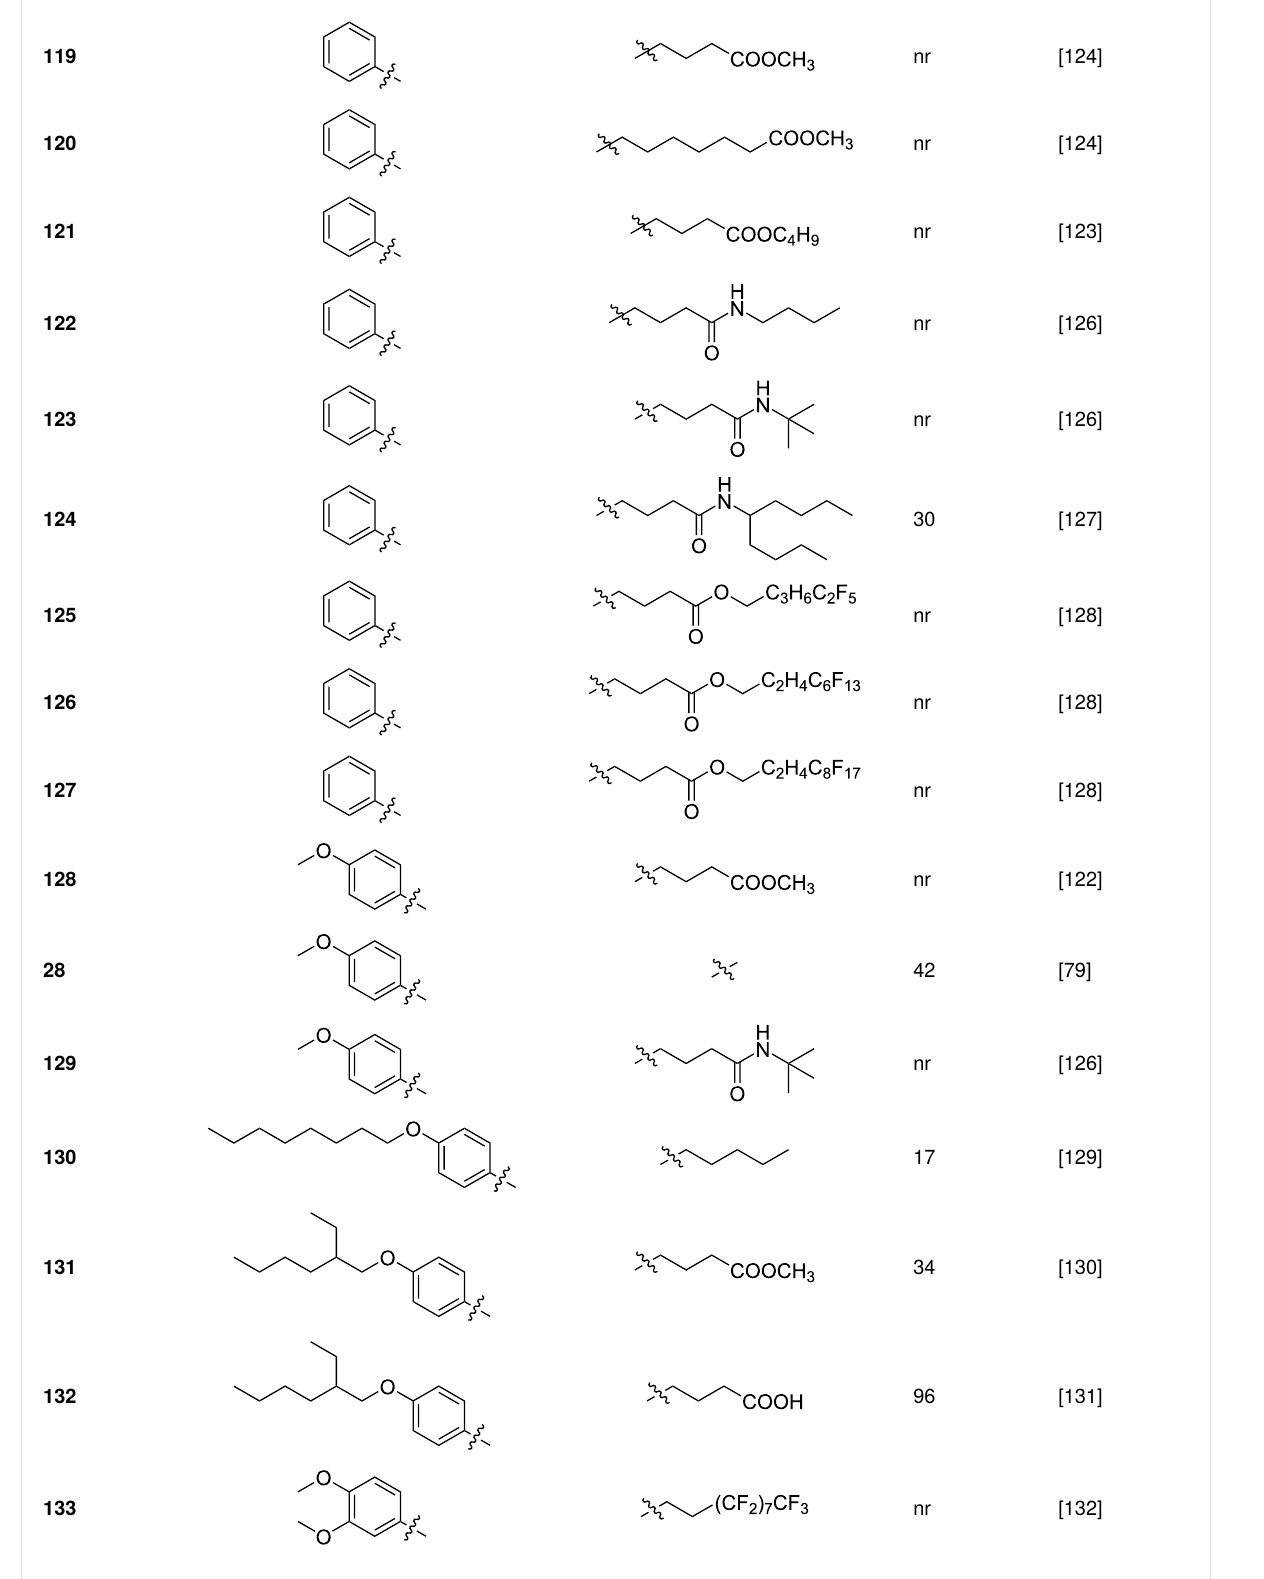
Table 1: [60]PCBM derivatives containing various aromatic and alkyl groups bound to the C 60 core. (continued)